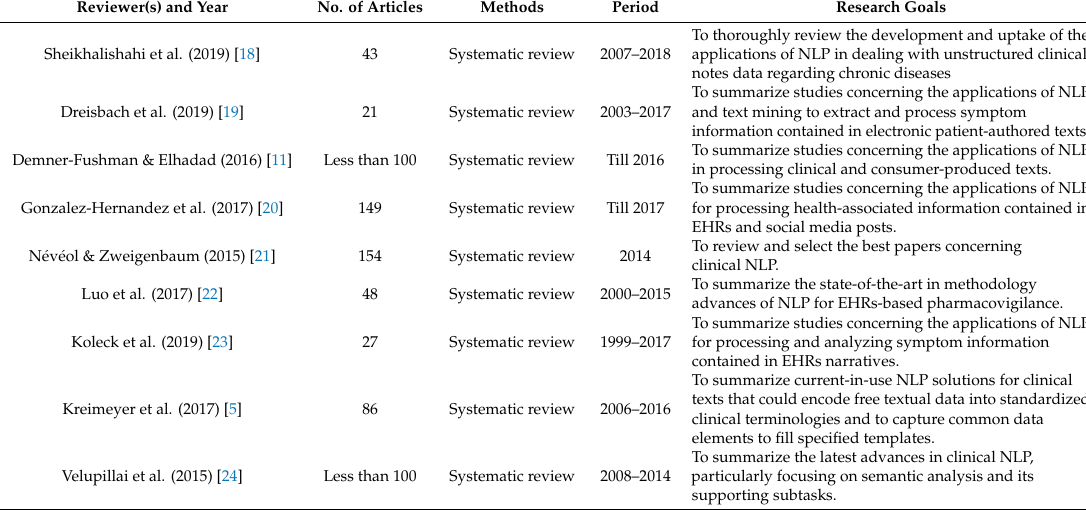
Table 1. Recent reviews on the natural language processing (NLP)-enhanced clinical trial research and its relevant